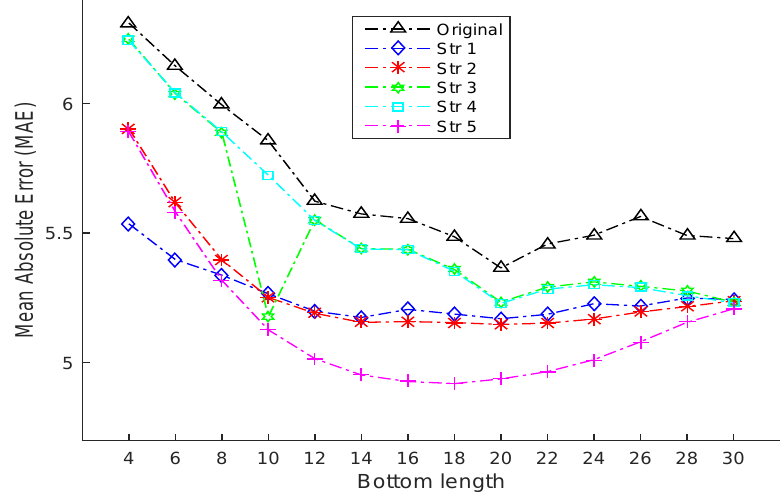
Figure 7. The line chart (variation tendency) of MAEs with respect to different bottom lengths for the original LDL algorithm and the proposed SDM-LDL algorithms with different strategies when age label distribution is generated as triangle .